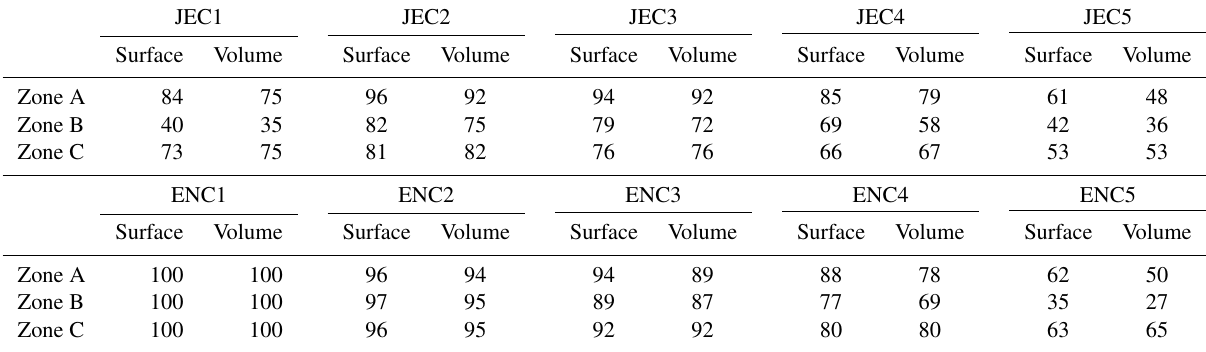
Table 7. Flooded surface and water volume for all the combinations relatively to the maximizing scenario (ENC1, environmental contour method – scenario 1) in %.